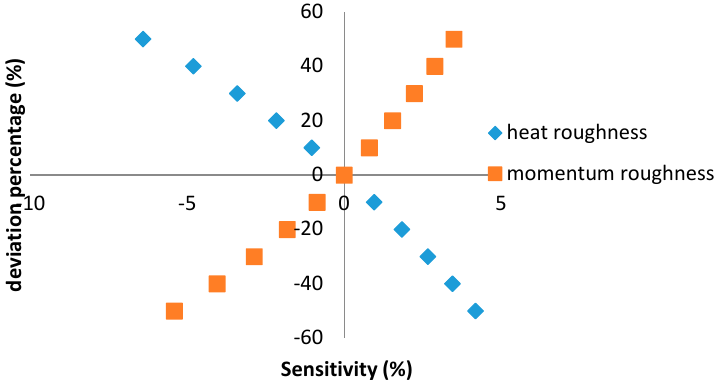
Figure 8. Sensitivity of estimated sensible heat to roughness heights for momentum and heat transfer.